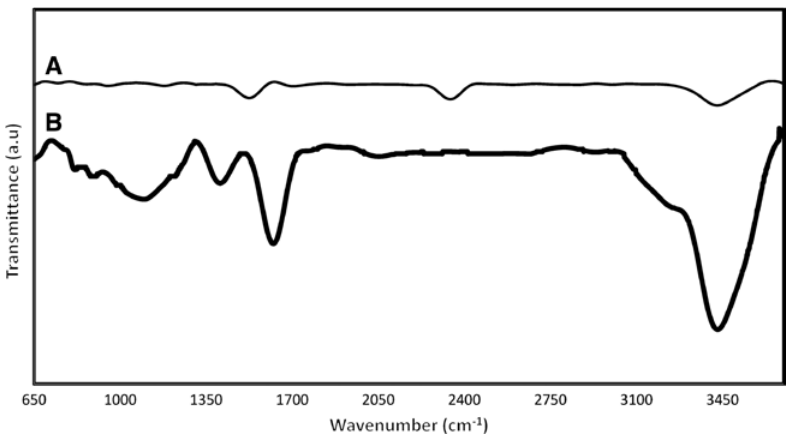
treatment at 80 ° 3